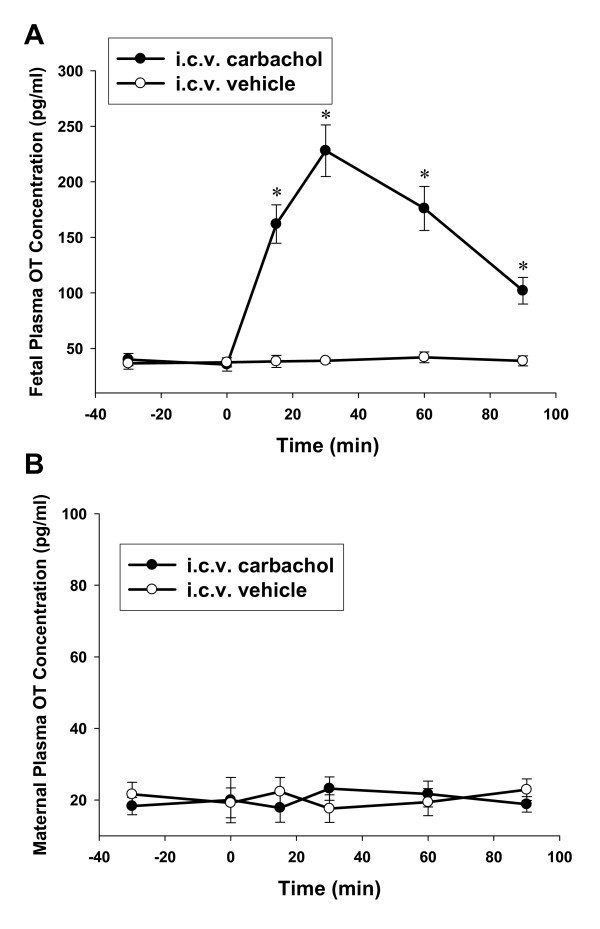
The effect of i.c.v. carbachol on fetal (A) and maternal (B) plasma OT concentration. The dose of carbachol, 3 μg/kg; 0 min: time for i.c.v. injection. *, P < 0.01 compared with the baseline level. OT: oxytocin.